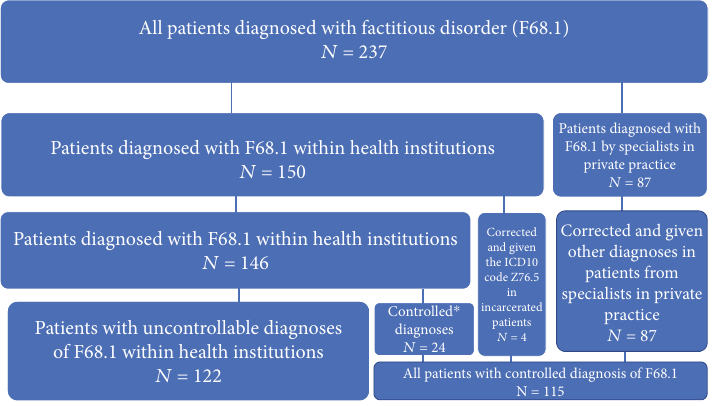
Figure 2: Flowchart showing, of the original patients who were assigned to a factitious disorder between 2008 and 2016 in the Norwegian Patient Registry, for how many the diagnosis could be controlled and eventually corrected. Of the original 237 patients, 122 patients within health institutions remained with uncontrollable